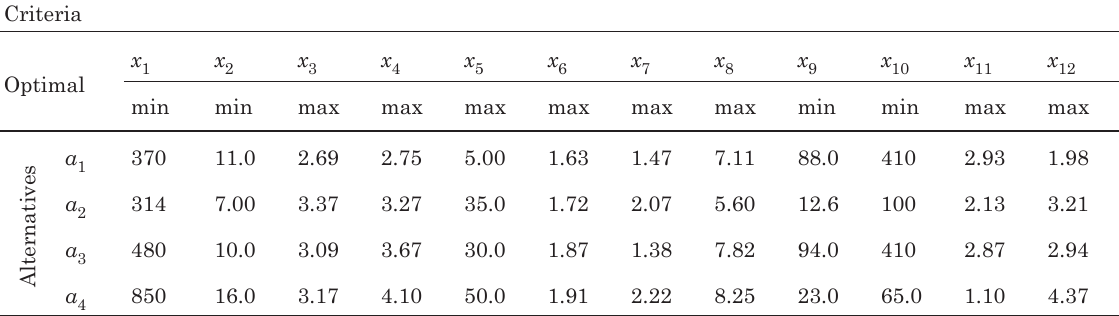
table 2. Initial decision-making